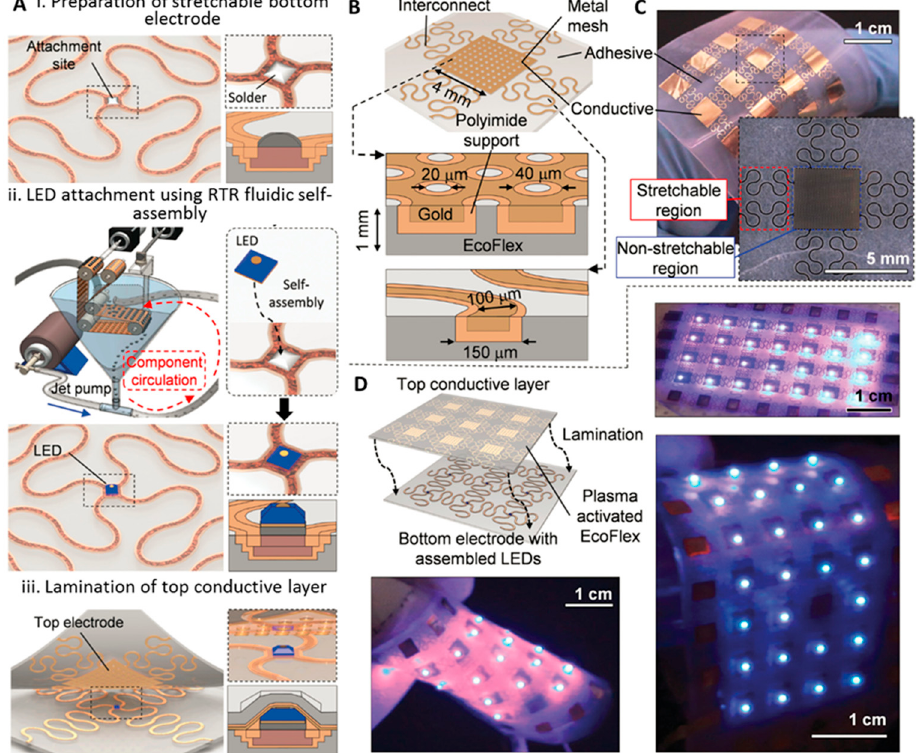
Figure 7. ( A ) Overview of the three basic steps used to fabricate a rubber-like solid-state lighting module: (i) preparation of a stretchable bottom electrode with solder-coated attachment site; (ii) the attachment of the LEDs using solder-directed fluidic self-assembly; and (iii) the lamination of a stretchable top conductive layer. ( B ) Schematics and ( C ) photographs describing the design, fabrication, and application of the stretchable top conductive lamination layer next to results of a completed 2 mm thin rubber-like module under test. (B) The designed laminate is a composite made up of: (i) conductive and (ii) adhesive, as well as (iii) stretchable (meander), and (iv) non-stretchable (metal mesh) regions; oxygen plasma-activated EcoFlex acts as an adhesive during the lamination process. ( C ) Photographs of the realized stretchable top conductive laminate. ( D ) The lamination is